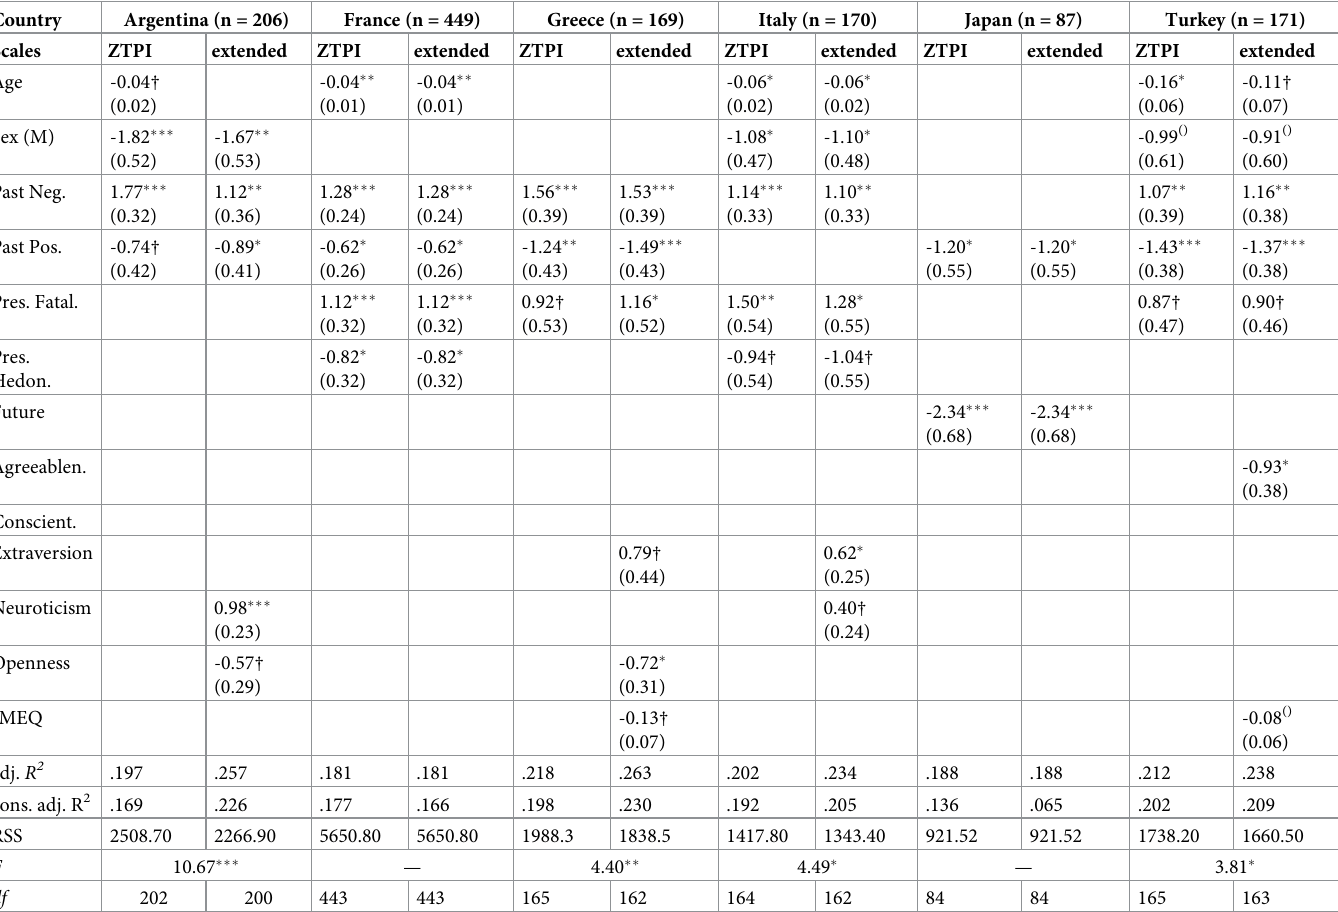
Table 5. Final models for depression after stepwise regression (country-wise, with two models each (1 st : ZTPI, sex, and age as predictors; 2 nd = extended: ZTPI, sex, age, BFI, and rMEQ as predictors)). Country Argentina (n = 206)